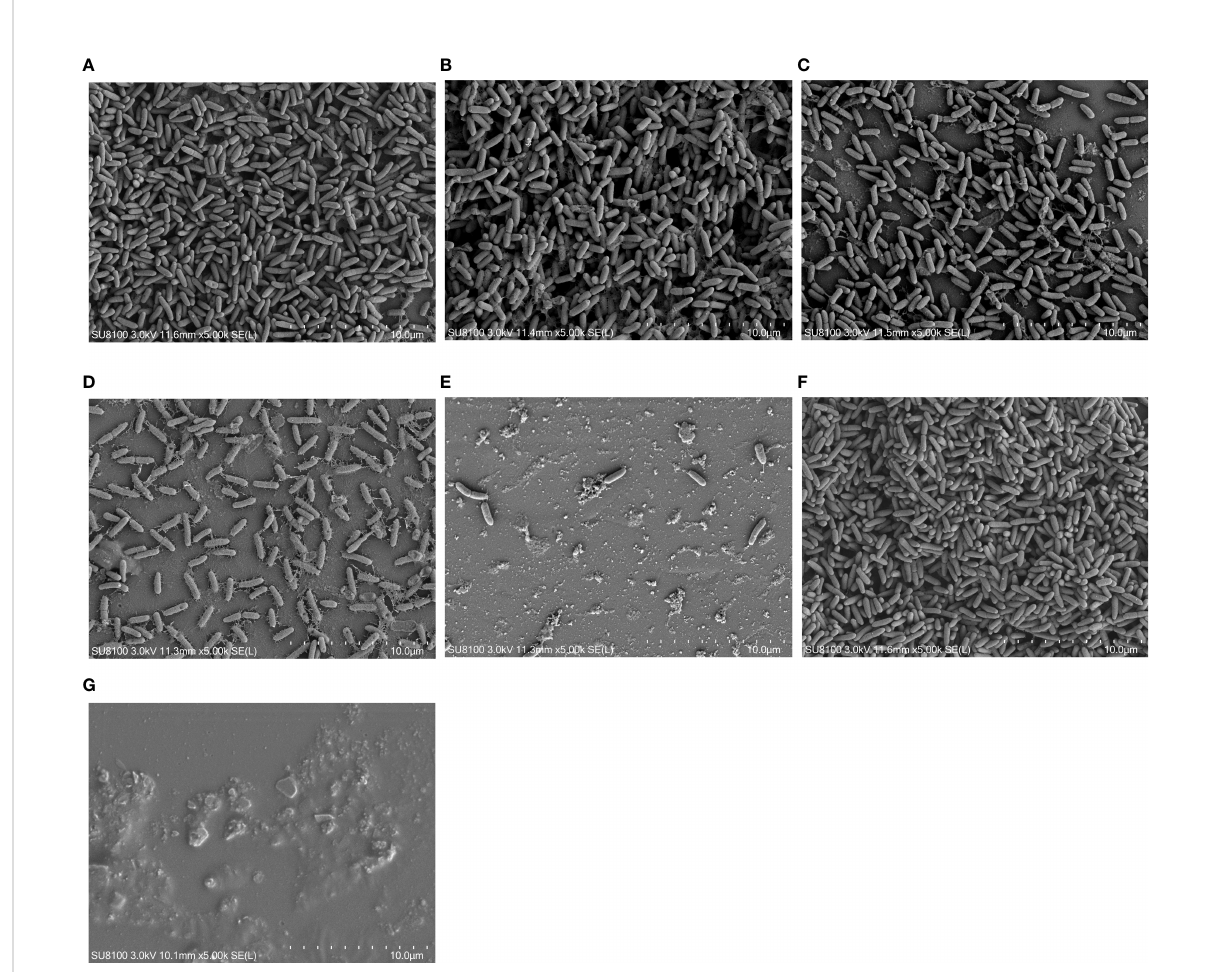
FIGURE 5 Inhibitory effect of daphnetin (DAP) on bio fi lm formation of P. aeruginosa is observed by electron microscopy after 24 h in culture (×5000). (A) PAO1 group. A large number of aggregated P. aeruginosa and their secreted matrices form the bio fi lm. (B) DAP group with fi nal concentration of 0.222 (mg/ mL). (C) DAP group with fi nal concentration of 0.445 (mg/mL). (D) DAP group with fi nal concentration of 0.890 (mg/mL). (E) DAP group with fi nal concentration of 1.781 (mg/mL). In the DAP groups, bacterial aggregation decreased with increasing concentration, and a few shriveled bacteria can